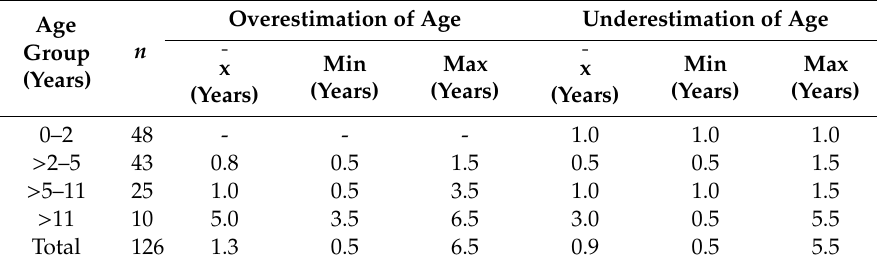
Table 3. Di ff erences between the estimated ages of Icelandic horses as determined on the basis of the appearance of their incisors and their real